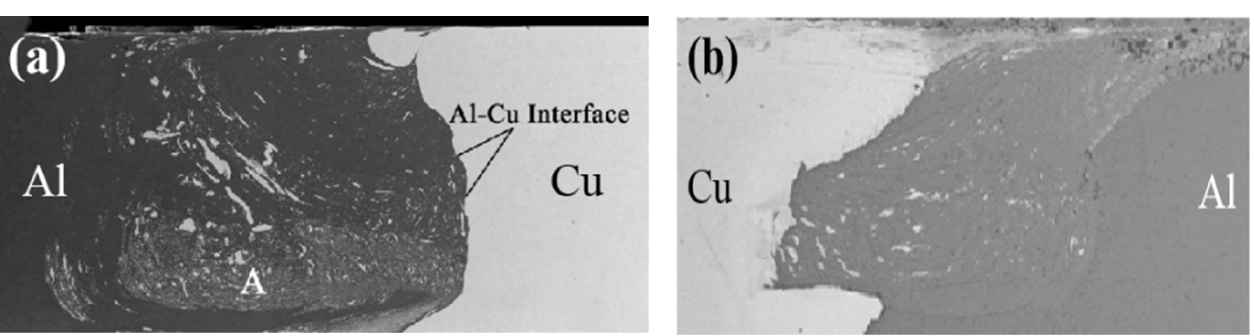
Figure 15. ( a ) SEM backscattered electron images (BEI) of the FSW Al–Cu joint (from ref. [3]); ( b ) SEM microstructures of the FSW Al–Cu welded joint in NZ (from ref. [62]).